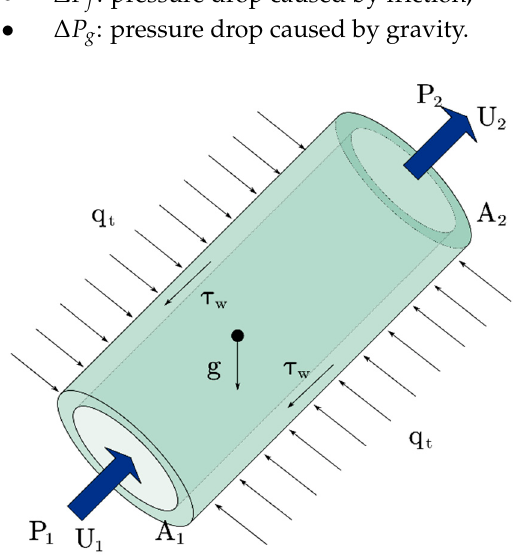
Figure 4. Diagram of wellbore fluid flow.